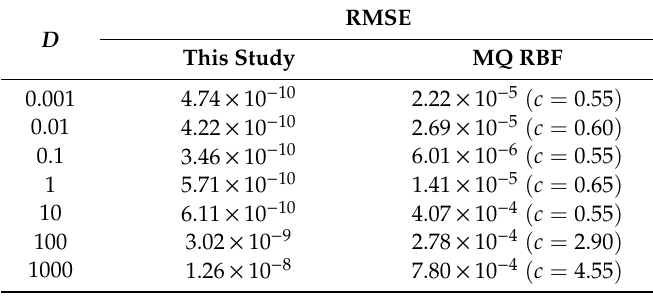
Table 2. RMSE of the proposed approach and the MQ RBF for the di ff usivity of the coe ffi cient. D